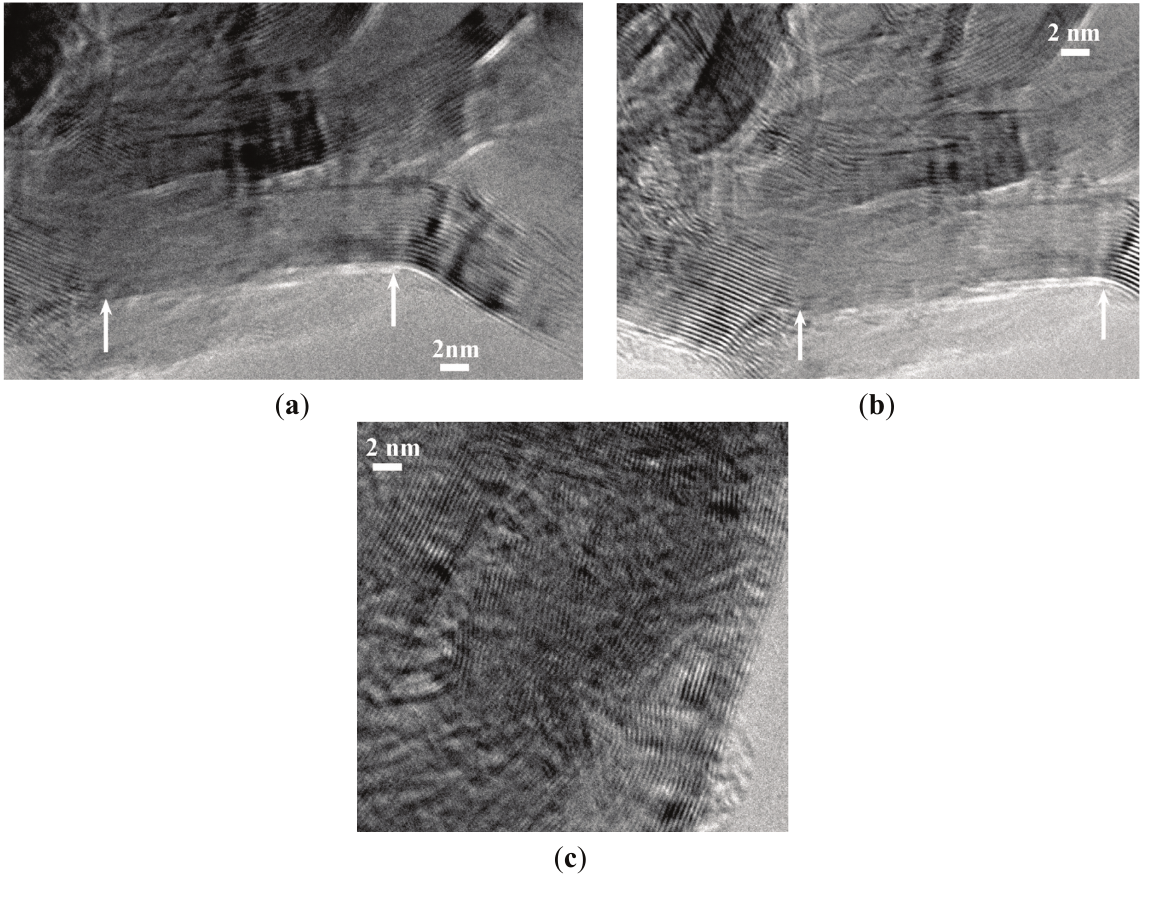
Figure 6. HRTEM images of the sample B cleavage of the walls in the area delimited by the white arrows, and in ( c ), a disordering of the stacking